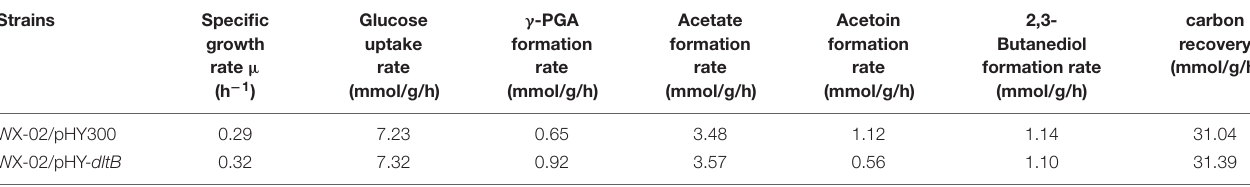
TABLE 2 | The fermentation characteristics of WX-02/pHY300 and WX-02/pHY- dltB . Strains